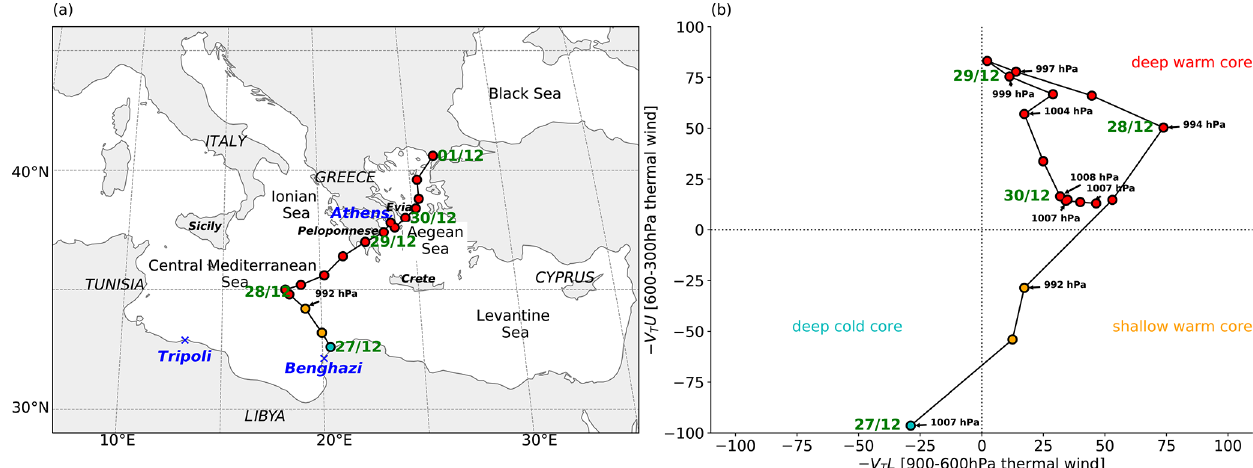
Figure 3. (a) Track of Medicane Zorbas (circles and black line) and (b) cyclone phase space diagram derived from the ECMWF operational analyses, at 6-hourly intervals in each panel. Cyclone positions are colored according to the quadrant in the CPS diagram (blue: cold core, orange: shallow warm core, red: deep warm core). Black numbers indicate the minimum sea level pressure (hPa) of the cyclone at this particular time of its life cycle, and green numbers represent the day (in September 2018) and time (hours